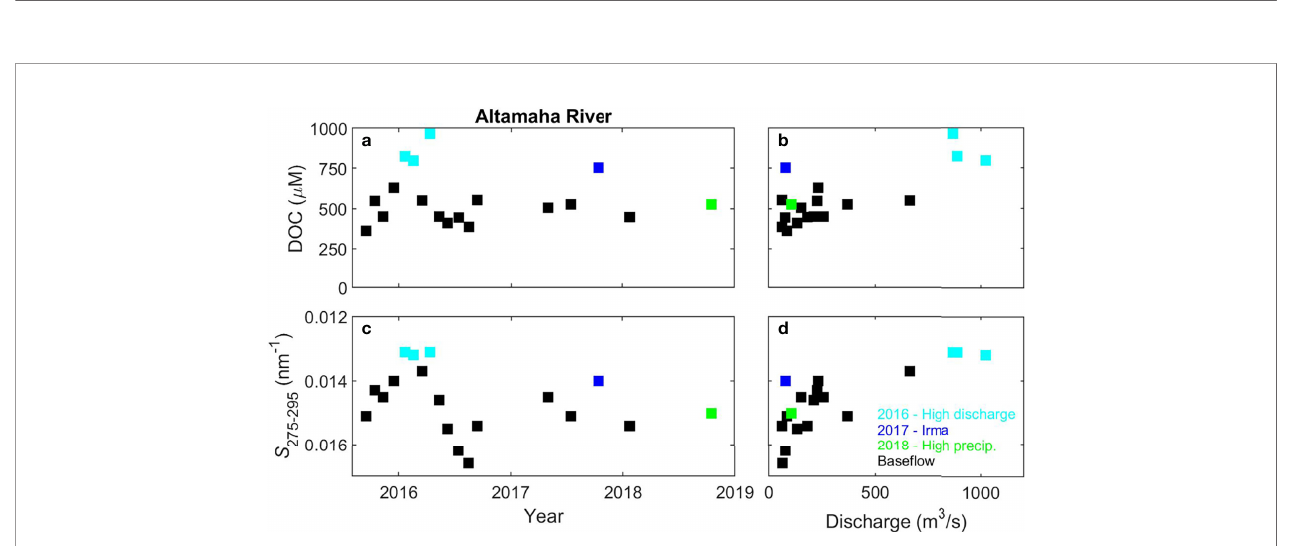
FIGURE 5 | Time series of (A) DOC concentration and (C) spectral slope coef fi cients ( S 275-295 ) at the Altamaha River. (B) DOC concentration and (D) spectral slope coef fi cients are also plotted versus river discharge. Small spectral slope coef fi cients indicate a stronger terrigenous signature.